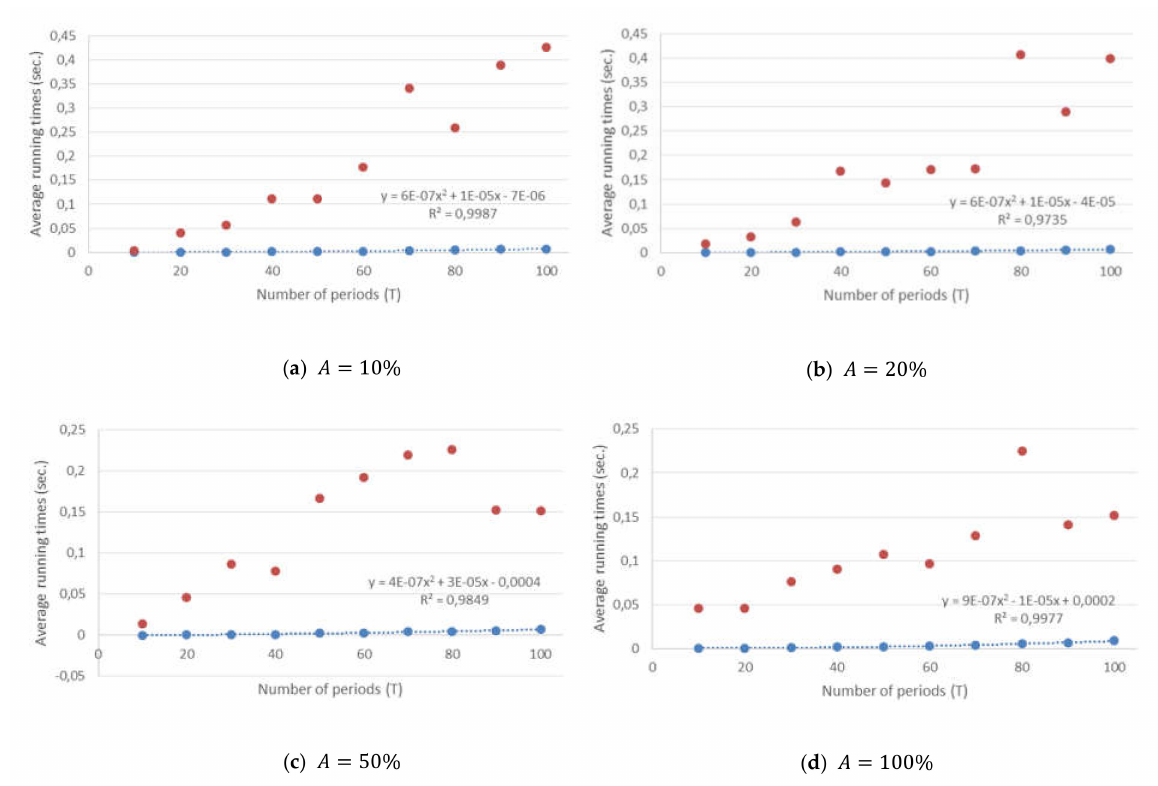
Figure 1. Comparison of average running times for different values of A reported by CPLEX (in red) and Algorithm 1 (in